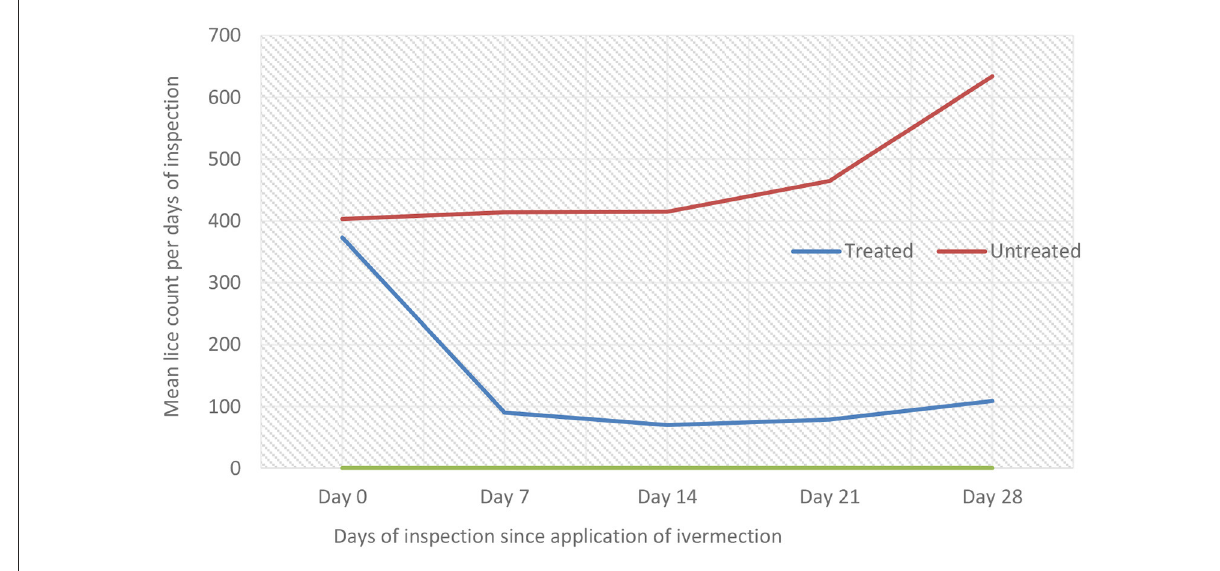
FIGURE3 Effect of ivermectin treatment on sheep lice infestation (mean lice count) among treated and untreated groups per days of inspection in Sayint district.